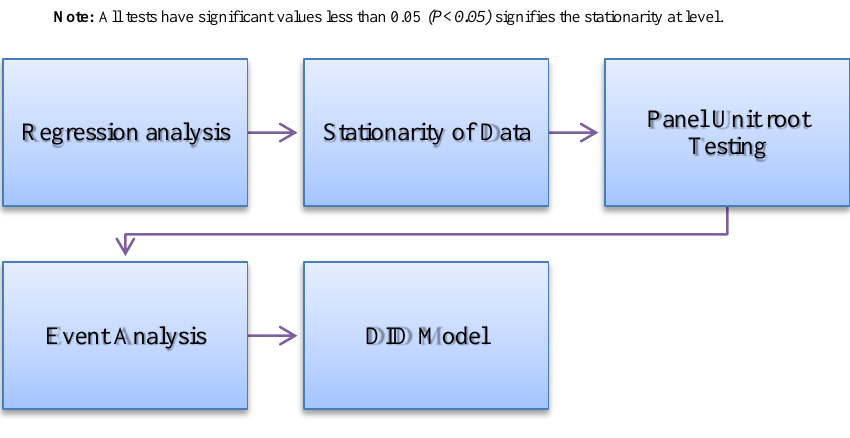
Figure 2. Methodology Flow